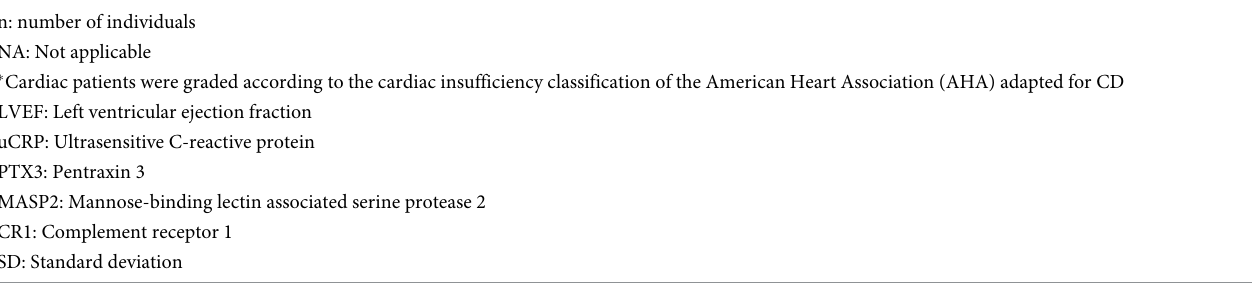
and normal echocardiogram (ECHO), absence of cardiac insufficiency (CI); B1 , altered ECG, left ventricular ejection fraction (LVEF) > 45%, absence of CI; B2 , altered ECHO, LVEF < 45%, absence of CI; C , altered ECG and ECHO, compensable CI; D , altered ECG and ECHO, refractory CI. The digestive forms of Chagas disease were identified by alterations in esophagography and barium enema radiological exams, used to diagnose megaesophagus and/ or megacolon. Chronic asymptomatic individuals (with the indeterminate form) presented reactive serology and/or positive parasitological examination for T . cruzi but did not present clinical symptoms specific to CD and had normal results of ECG and radiological chest, esoph- agus and colon exams [30].